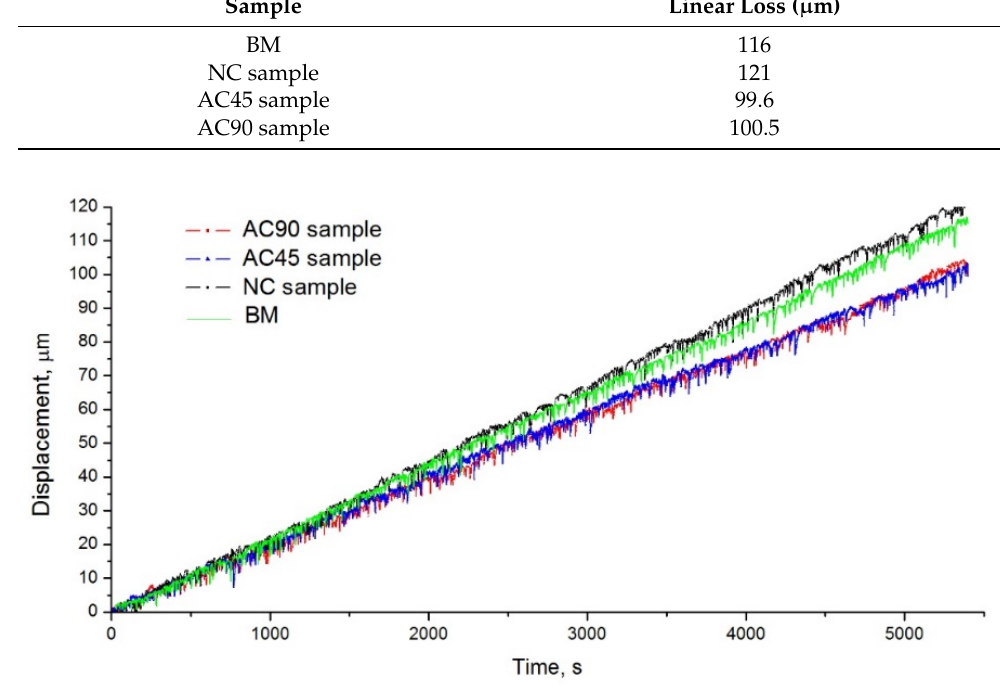
Figure 14. Results of tribological test.